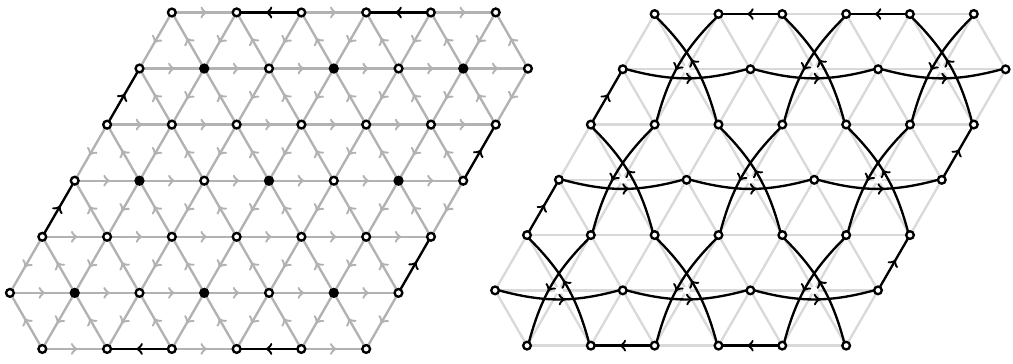
Figure 8 . Reflective boundary conditions. Left: the k = 3 × 3 moose lattice from figure 2 is modified by the addition of eight “wrong-way” bifundamental quarks on the boundaries of the lattice. The wrong-way quarks are depicted in black; the matter fields already present in the section 2 are shown in gray. Following the concise notation of the figures in section 3, the SU( N ) and SU(3 N ) sites are represented (respectively) by white and black nodes. The only SU( N ) sites with nonzero SU( N ) 3 anomaly coefficients are those at the corners of the parallelogram. Right: after the SU(3 N ) groups confine, and after the mesons and quarks with vectorlike O (Λ 3 N ) masses are integrated out, the theory includes the SU( N ) charged quarks and mesons shown here. Thanks to the new edge quarks, the fields can be organized into three disjoint SU( N ) m − 1 gauge theories, two with m = 10 and one with m = 3